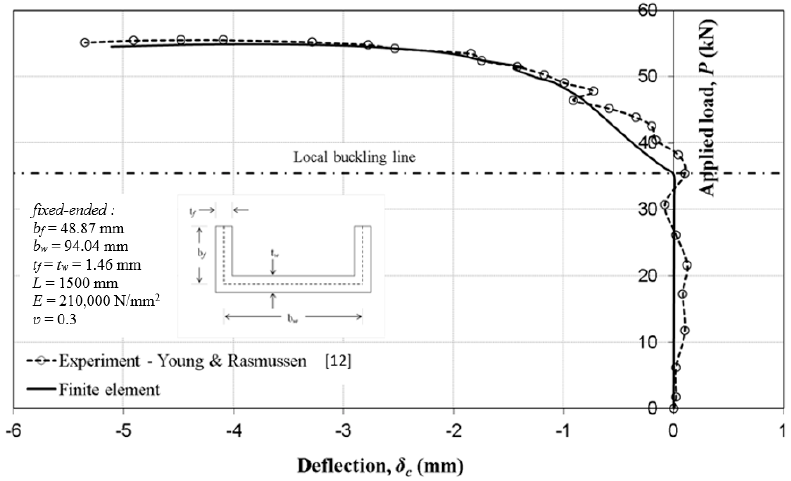
Figure 5. Column load–deflection comparisons with experimental tests.